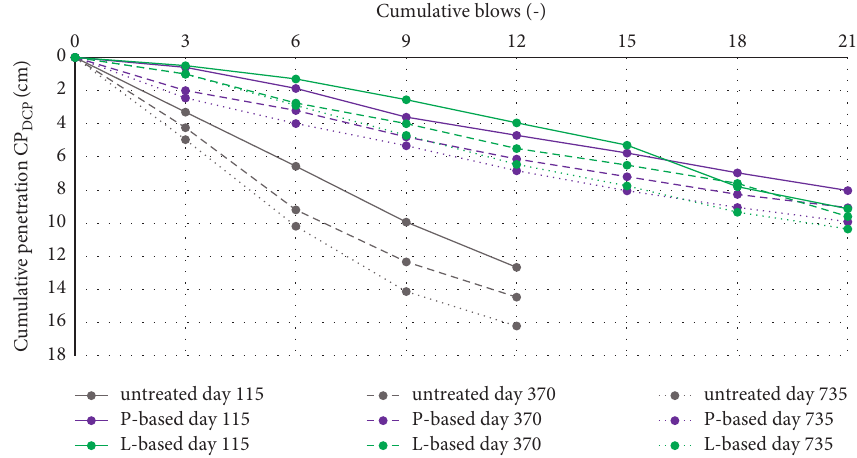
Figure 13: Cumulative penetration CP DCP measured on day 115, day 370 [24], and day 735.